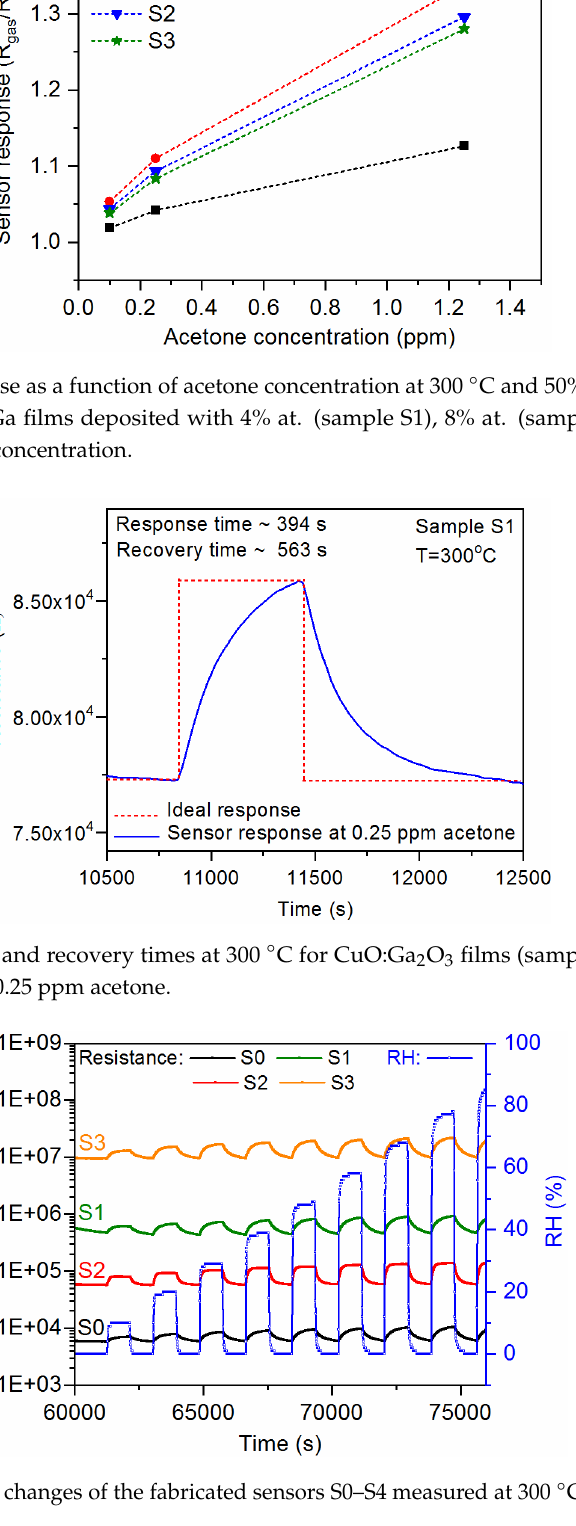
Figure 9. The resistance changes of the fabricated sensors S0 – S4 measured at 300 °C at various relative humidity levels.